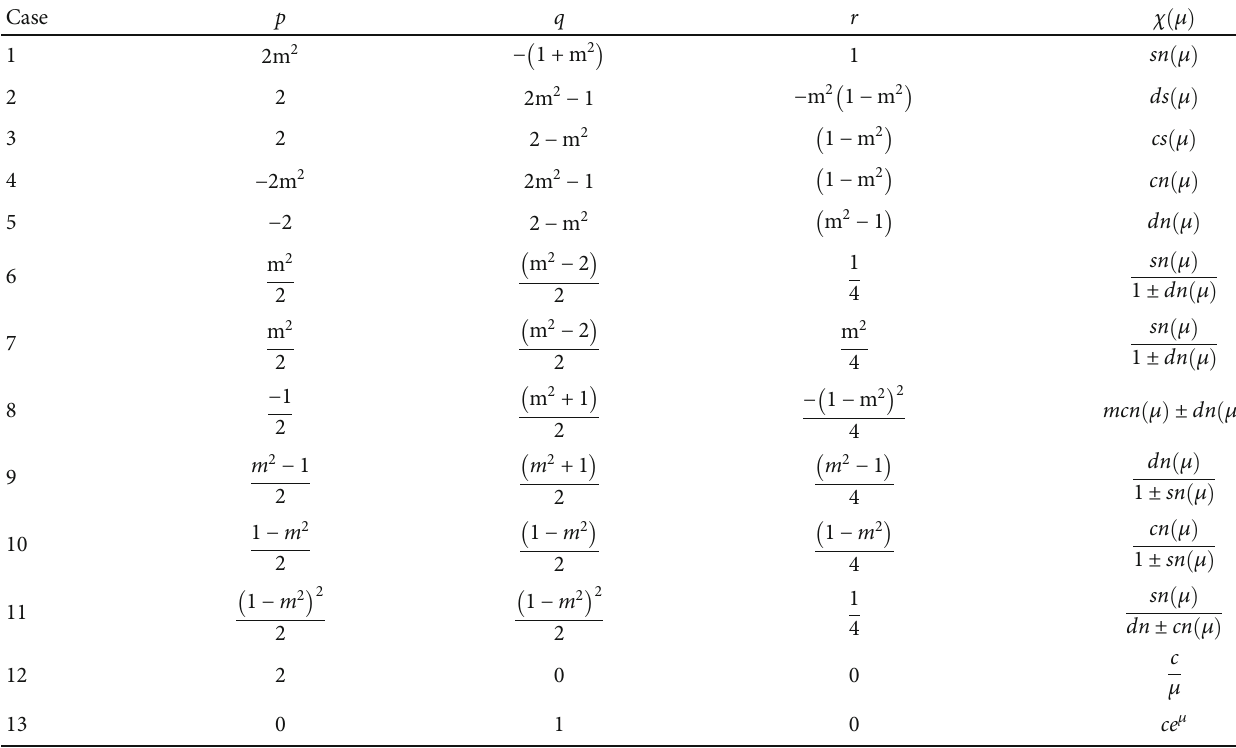
Table 1: All possible solutions for Equation (17) for di ff erent values of p , q , and r .